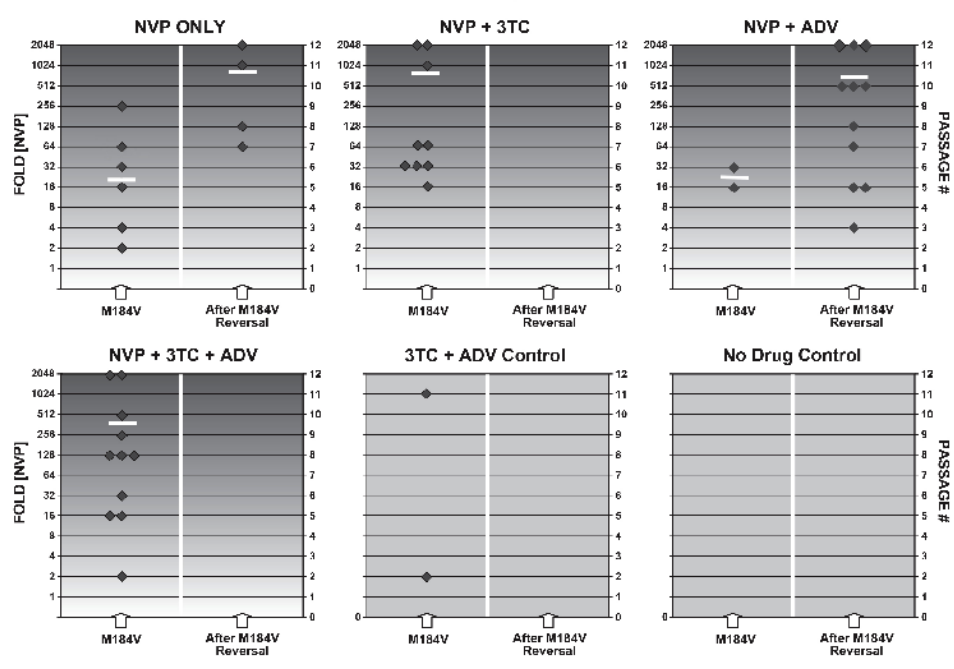
Figure 3. Appearance of new mutations before and after 184 Reversal: All mutations generated (diamonds) per drug setting, before ( M184V , left column) and after M184V-reversal ( After 184 Reversal , right column) are summarized. We display the appearance of each selected mutation in relation to the respective passage number and NVP concentration on the y-axis. FOLD [NVP] represents the concentration at which a mutation first became prevalent. FOLD [NVP] =2 p (with P = passage number). As reported in Figure 1, all observed mutations persisted up to P12. During drug escalation, the event of M184V-reversal is required for a mutation to appear in the right column. Diamonds in either column can therefore only be compared between different drug settings. Horizontal bars in the logarithmic FOLD [NVP] scale indicate the average [NVP] for mutations to